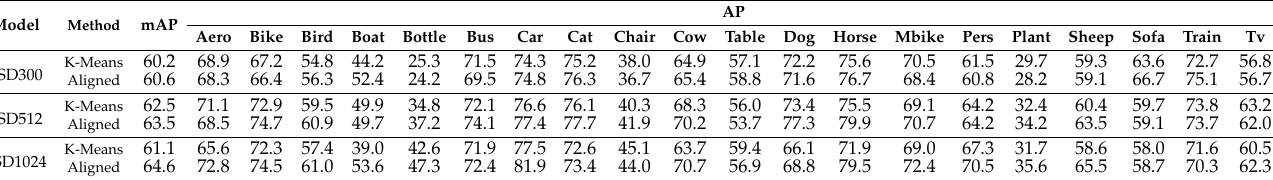
Table 7. SSD’s performance on Pascal VOC with K-means